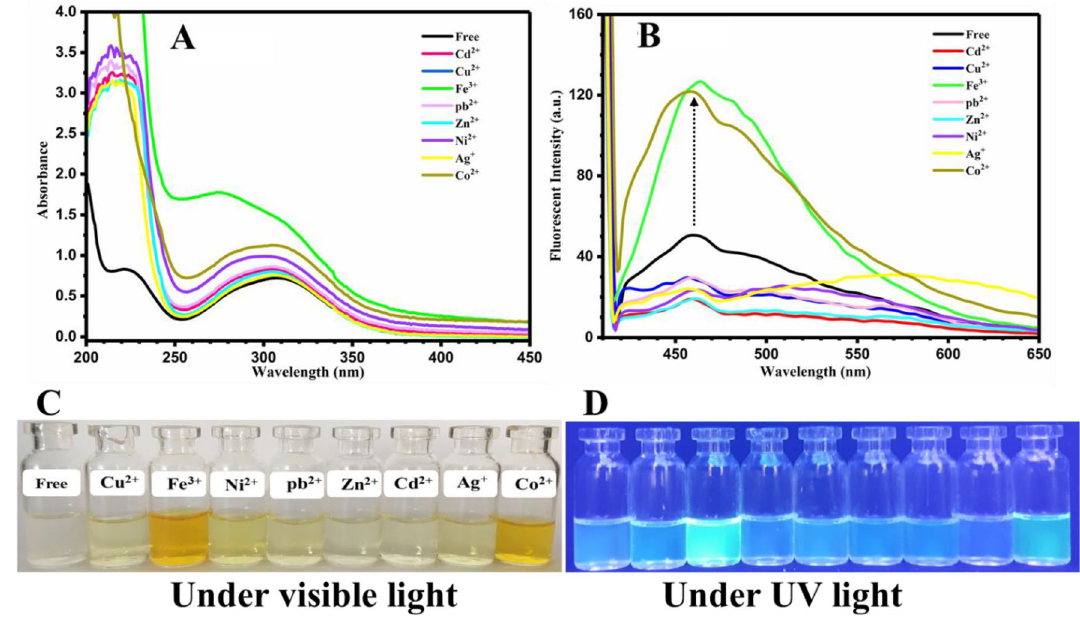
Figure 4. ( A ) UV–vis and ( B ) fluorescence spectra (excited with wavelength of 400 nm) of the OX 1 -Nitro aqueous solutions with a concentration of 0.0002 M containing metal ions with a concentration of 0.01 M, and photographs of ( C ) color change and ( D ) fluorescence emission of the OX 1 -Nitro/metal ions solutions under visible light and UV irradiation,